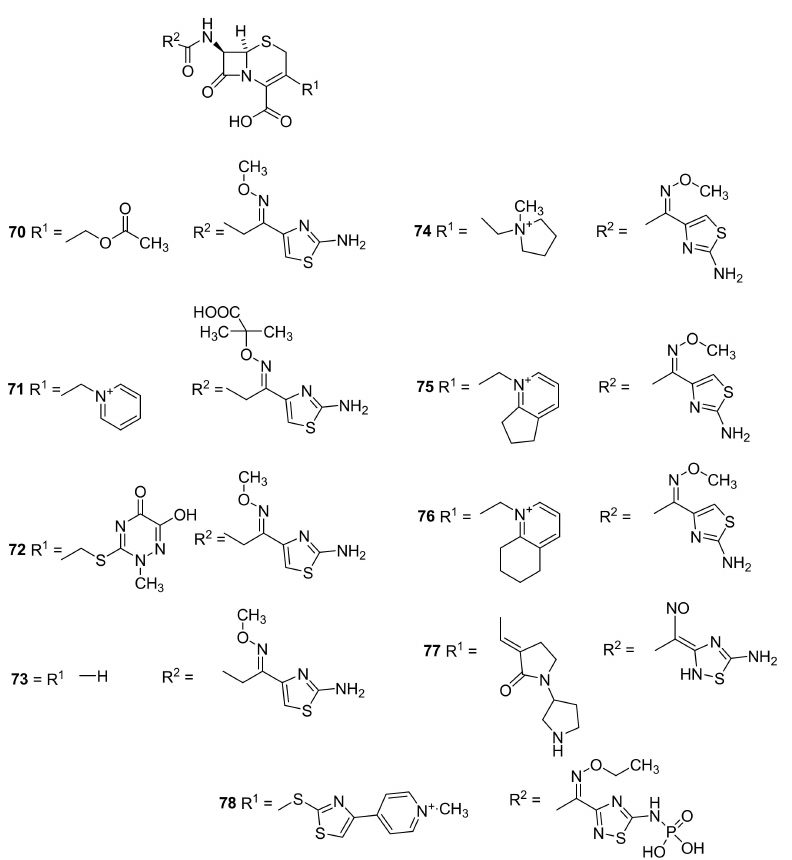
Figure 17. Third generation cephalosporins. Cefotaxime ( 70 ), ceftazidime ( 71 ), ceftriaxone ( 72 ) and ceftizoxime ( 73 ). Fourth generation cephalosporins. Cefepime ( 74 ), cefpirome ( 75 ) and cefquinome ( 76 ). Fifth generation cephalosporins: ceftobiprole ( 77 ) and ceftaroline fosamil ( 78 )